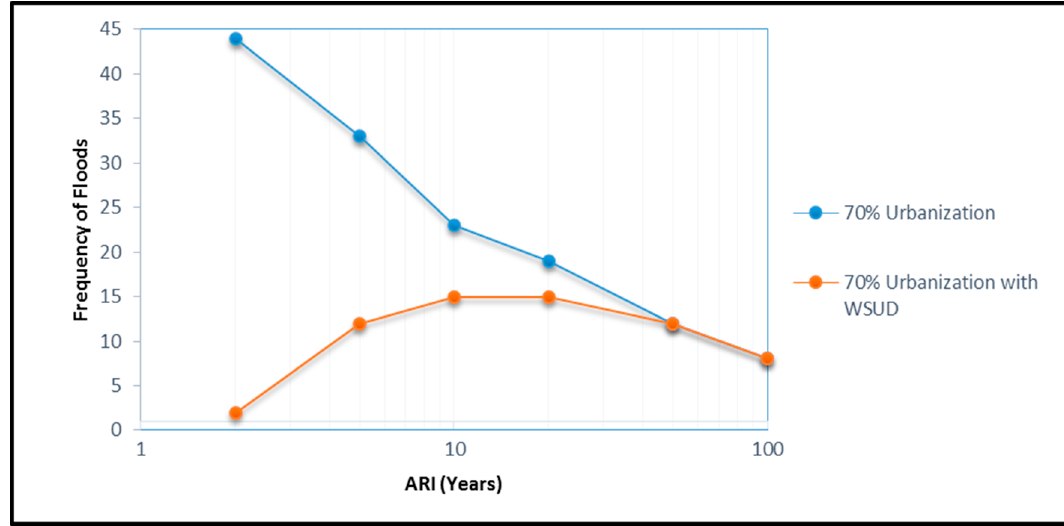
Figure 11. ( a ) Runoff comparison before and after Water Sensitive Urban Design (WSUD) for sub ‐